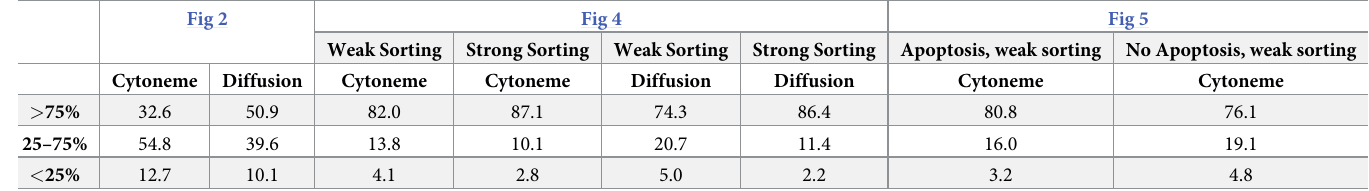
ronment determined at t = 180 min.